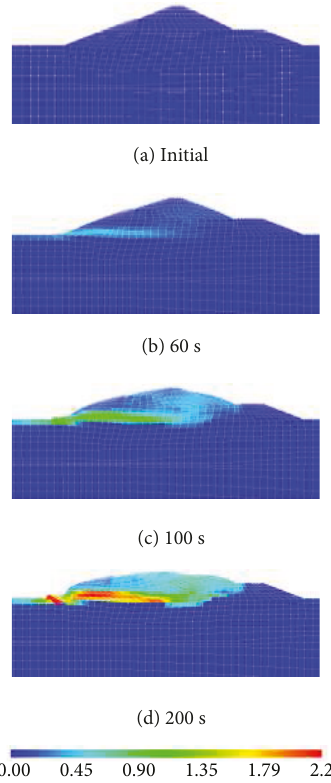
Figure 25: Distribution of skeleton stress decreasing ratio (ESDR).